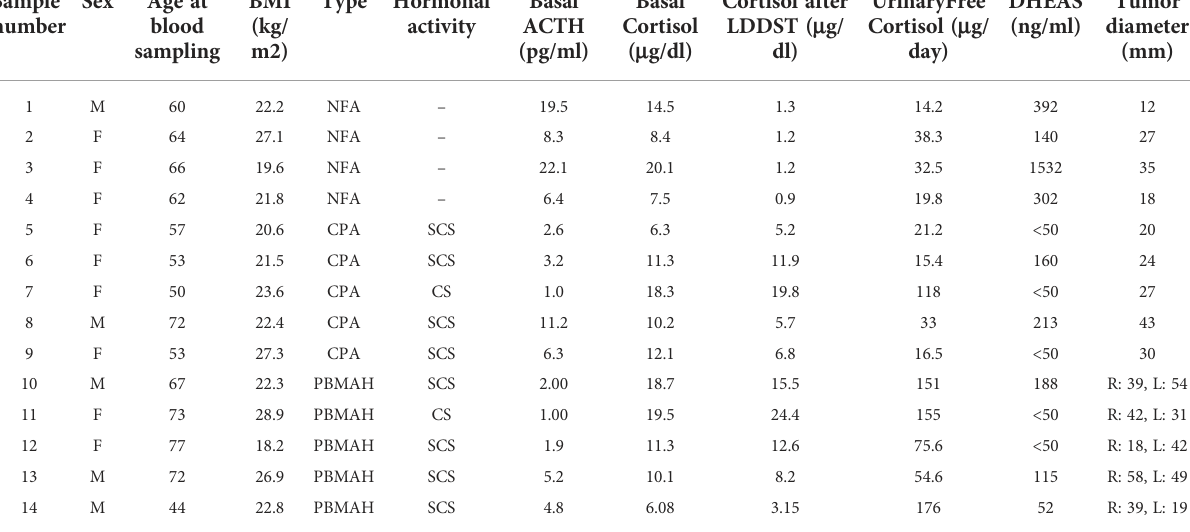
TABLE 1 Patient